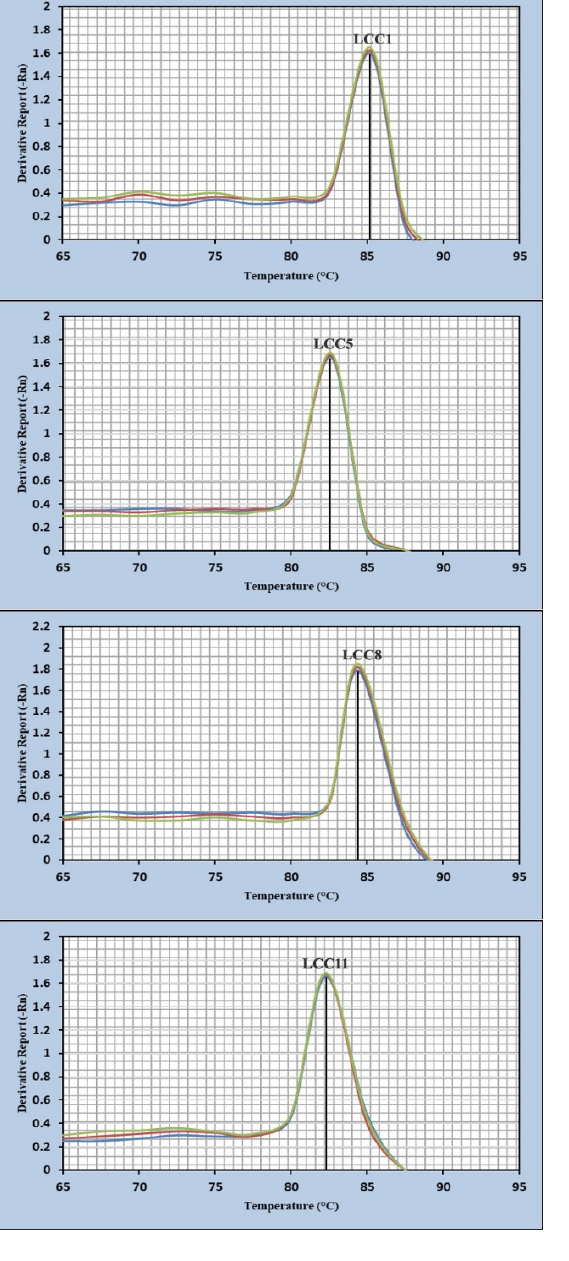
Figure 4. Melting curves of the Lcc gene amplicons of A. terreus